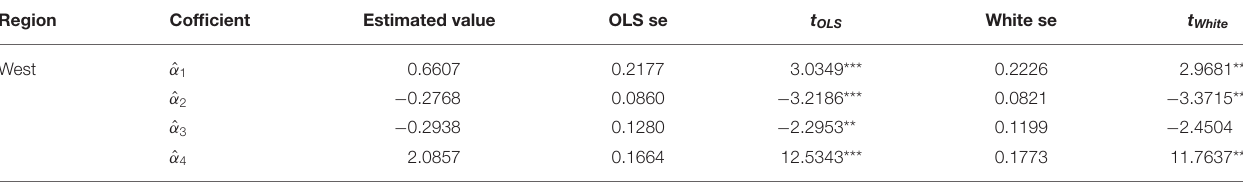
TABLE 7 | Estimated coefficients of the control variables. Region